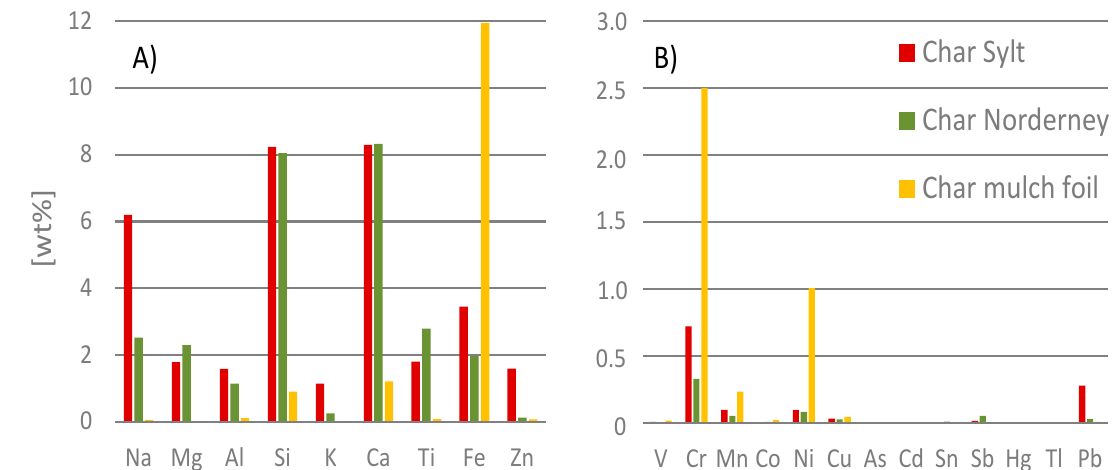
Figure 12. Mass fraction of selected elements in pyrolysis char determined by XRF (n = 2). ( A ) shows detected elements with the highest mass fractions. ( B ) shows heavy metals mentioned in the German ordinance for waste incineration (17. BImSchV).